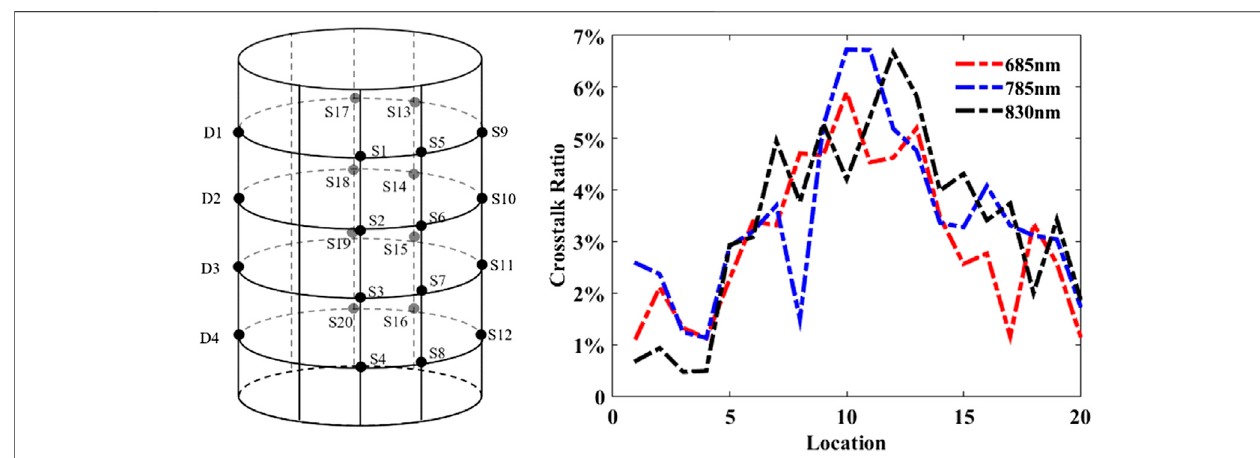
FIGURE 5 | Crosstalk assessments: source-detector array con fi guration (left) and the channel-to-channel crosstalk-ratio of 20 source locations at the wavelengths of 685 nm, 785 nm, and 830 nm (right) .